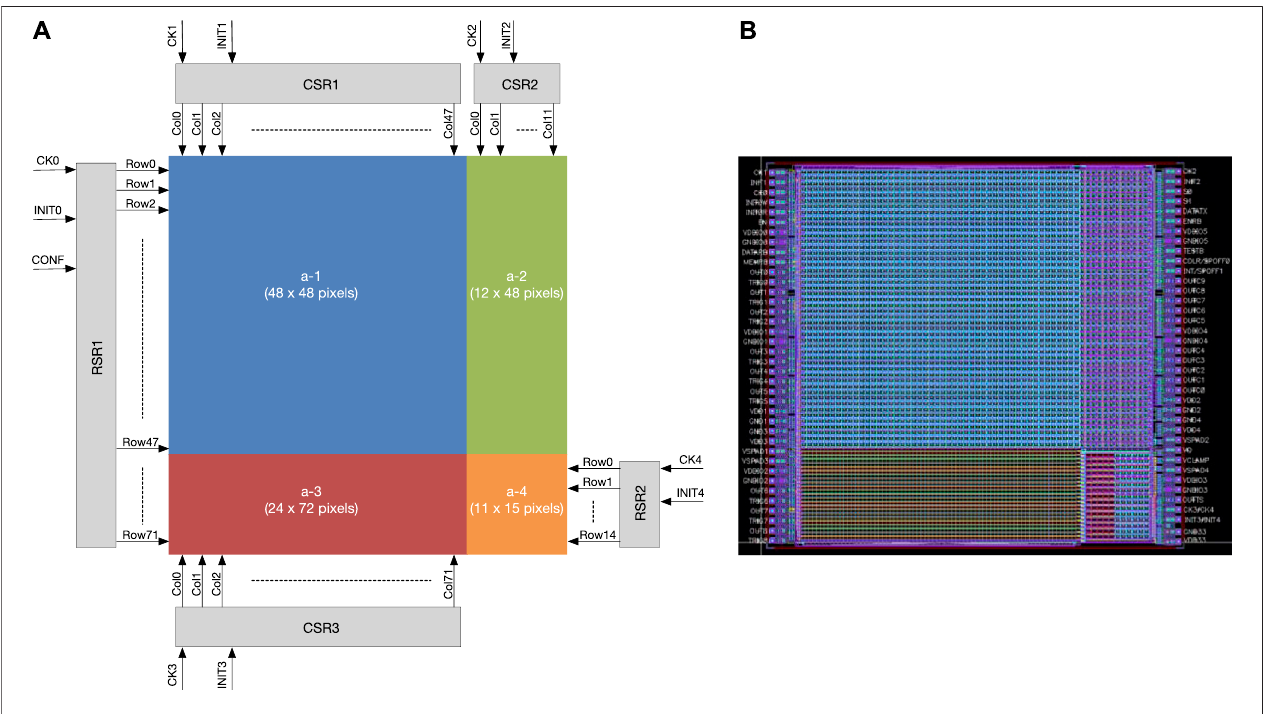
FIGURE 3 | Father chip: (A) schematic view of the four sub-arrays, with the shift registers for cell selection and enabling and (B) layout cell view.